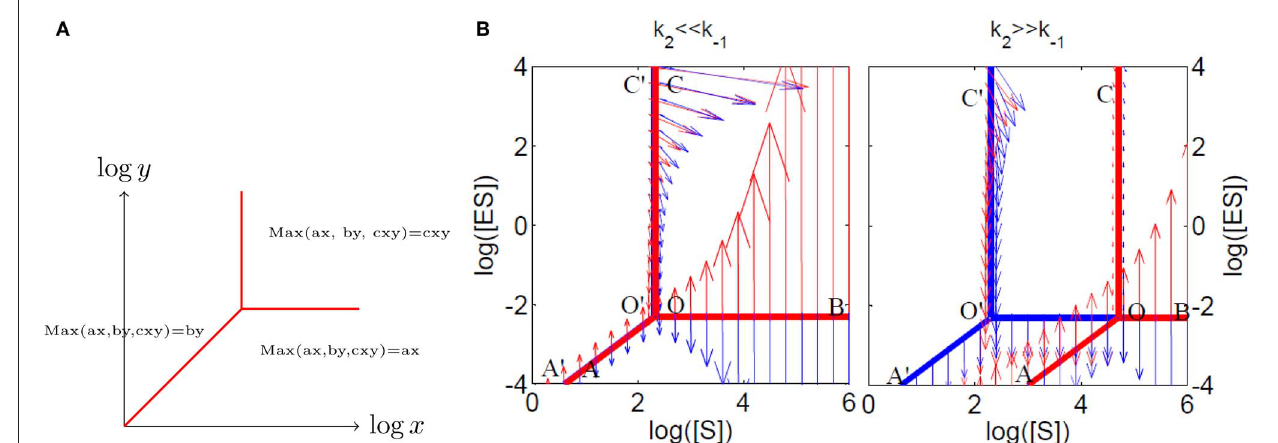
FIGURE 3 | Tropical geometry and Michaelis–Menten mechanism. (A) The tropical manifold of the polynomial ax + by + cxy on “logarithmic paper” is a three lines tripod. (B) The tropical manifolds for the species ES (in red) and S (in blue) for the Michaelis–Menten mechanism.